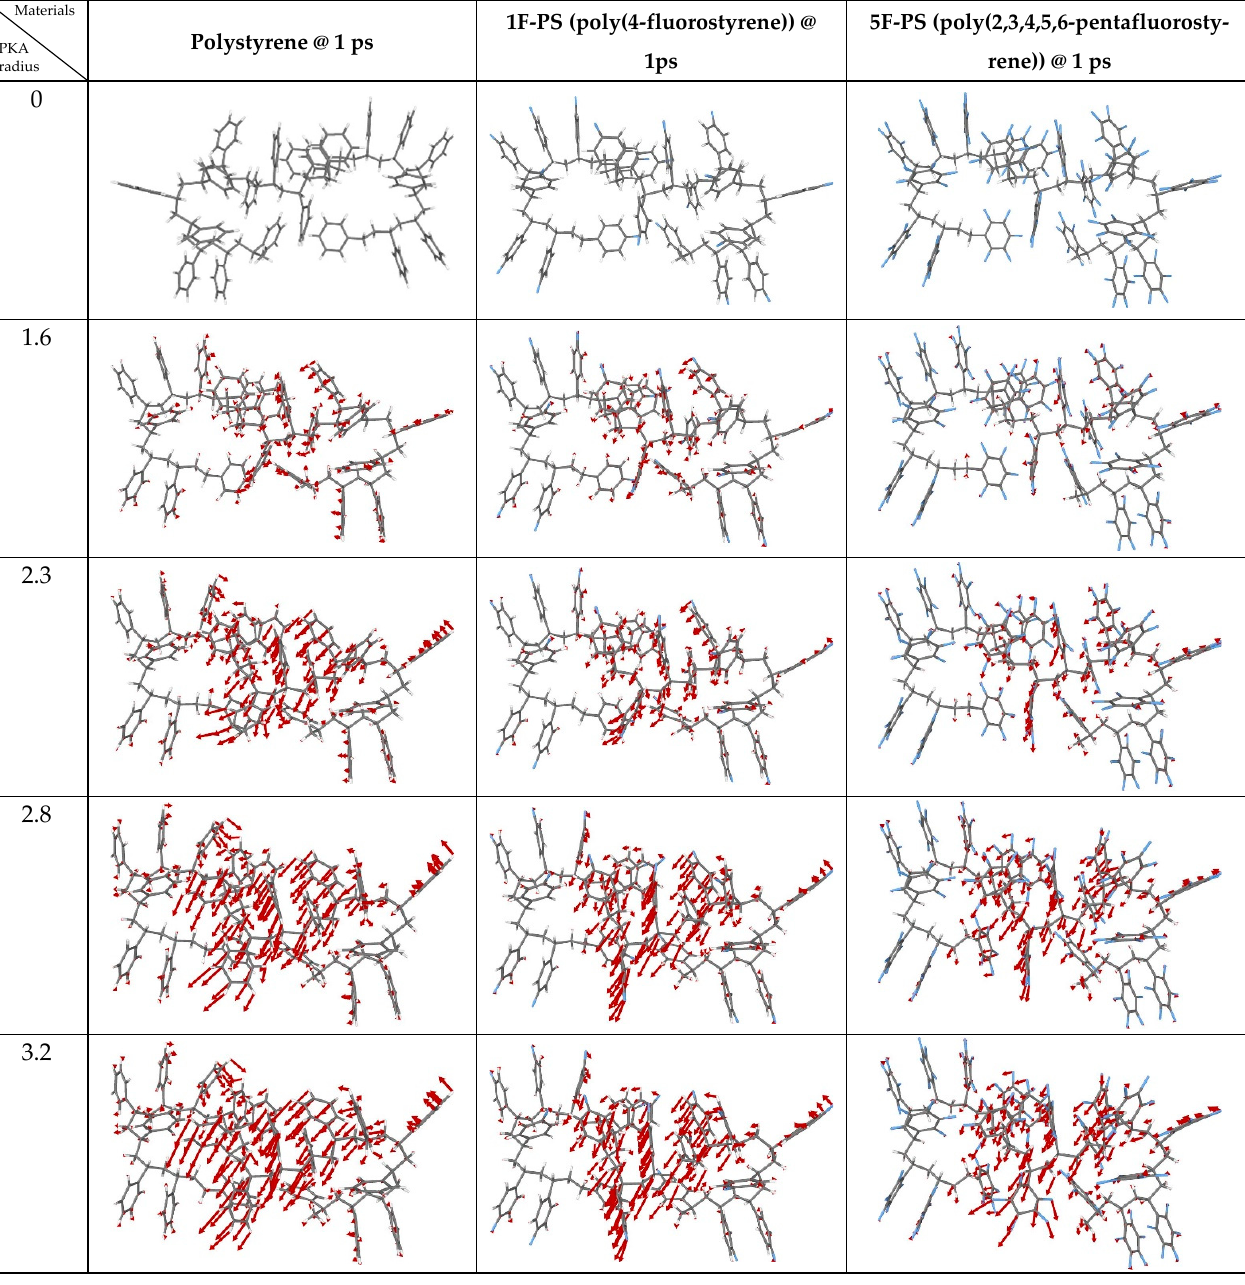
Figure 4. Snapshots of the displaced atoms’ velocity vector (conversion of γ -ray energy to kinetic energy-collision in the cascade zone) at the polymers @ 1 ps with increasing the PKA radius.